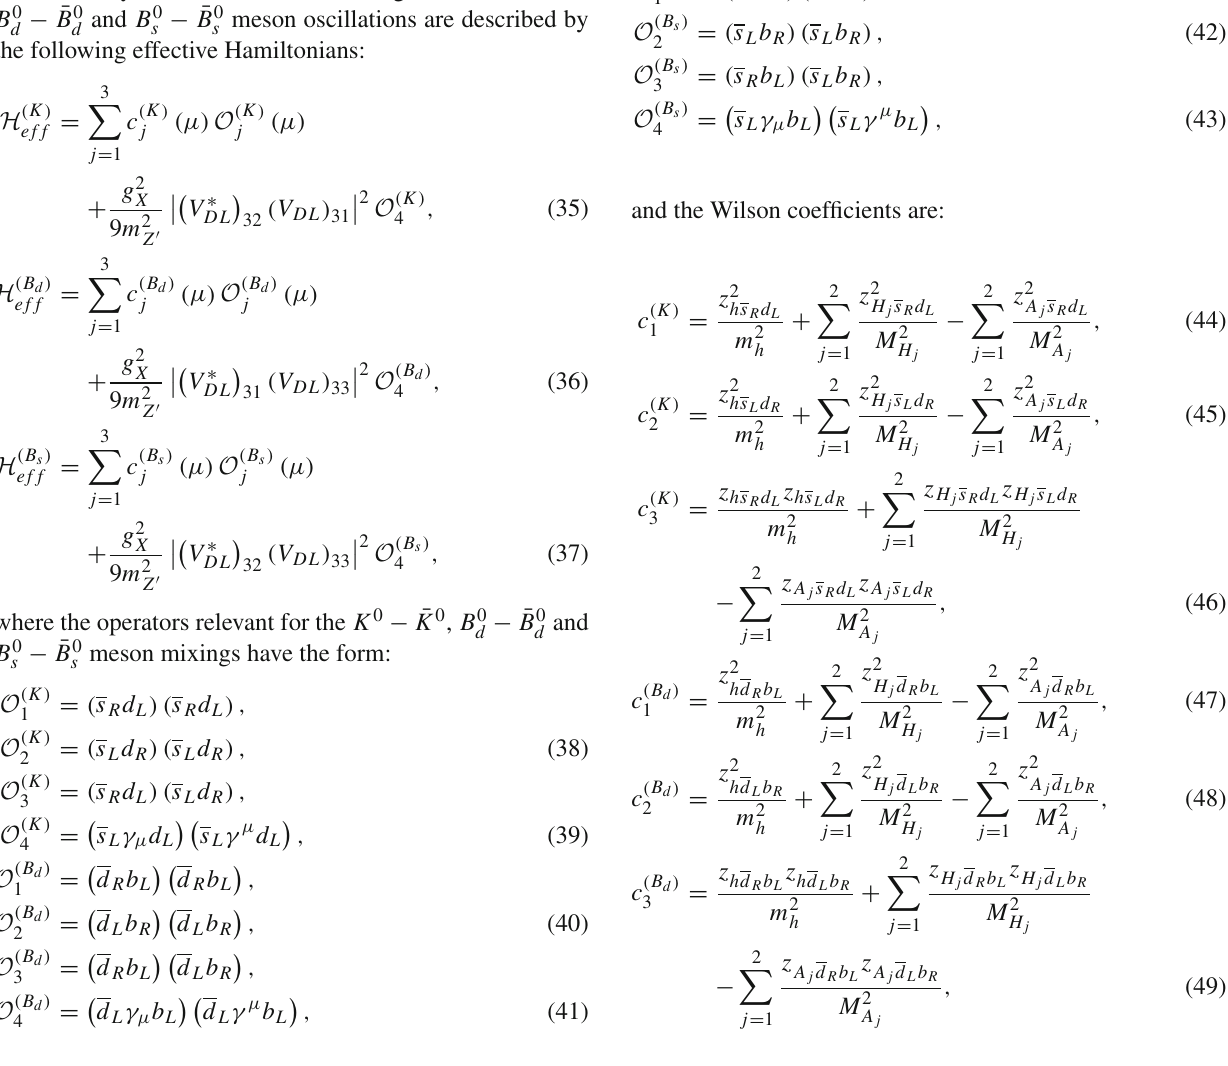
Fig. 3 Correlation between the masses of the scalars H 1 and H 2 consistent with the muon and electron anomalous magnetic moments as well as by the tree level Z (cid:2) exchange. The K 0 −